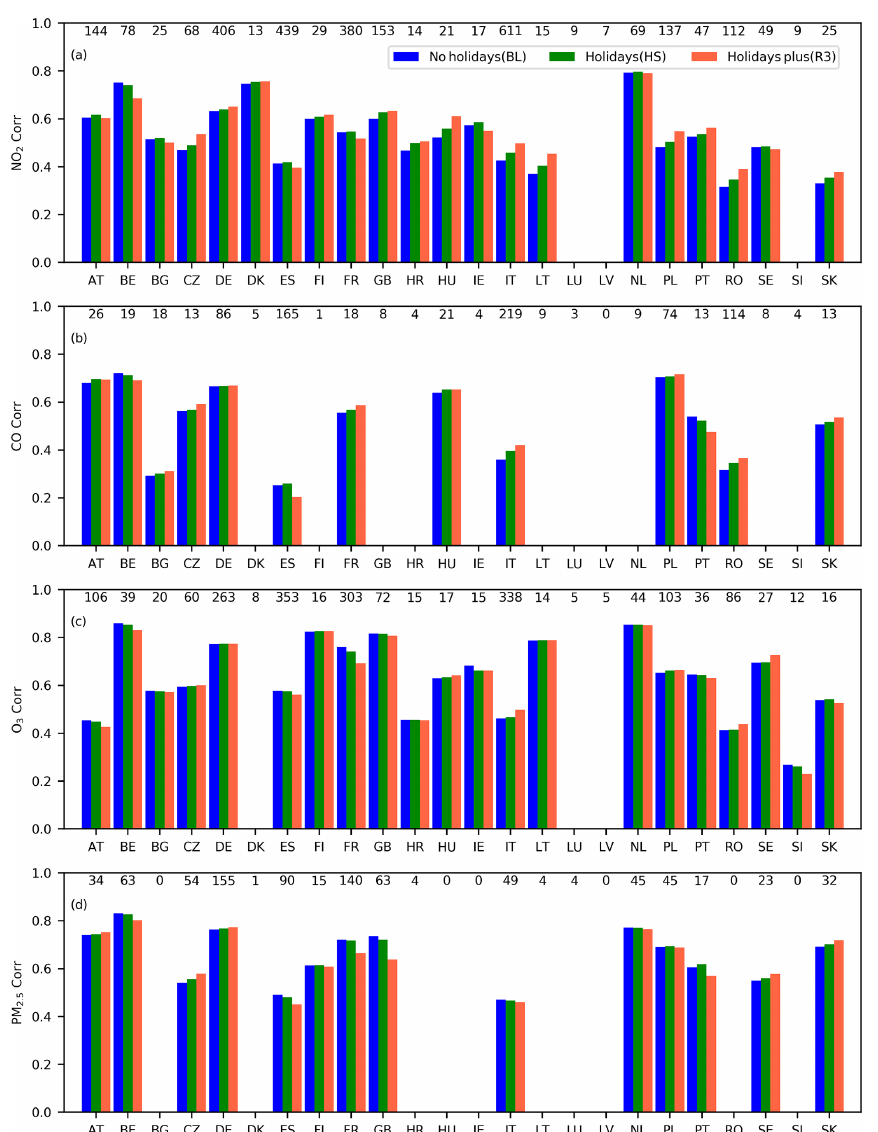
Figure 9. Country-wise median change in temporal correlation coefficient during the 2 weeks of Christmas holidays (21–31 December 2018). The numbers at the top of each panel show the number of stations that reported data for the